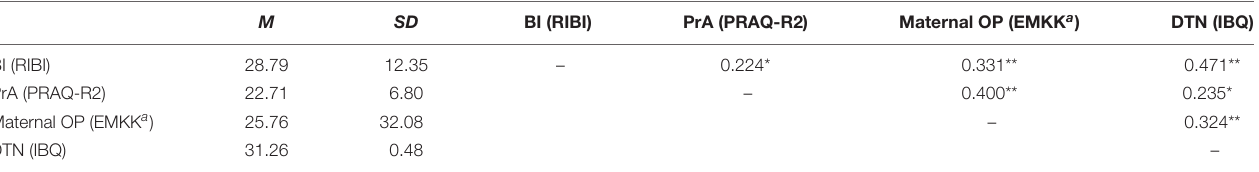
TABLE 2 | Zero-order correlations for the outcome, predictor, and moderator variables.